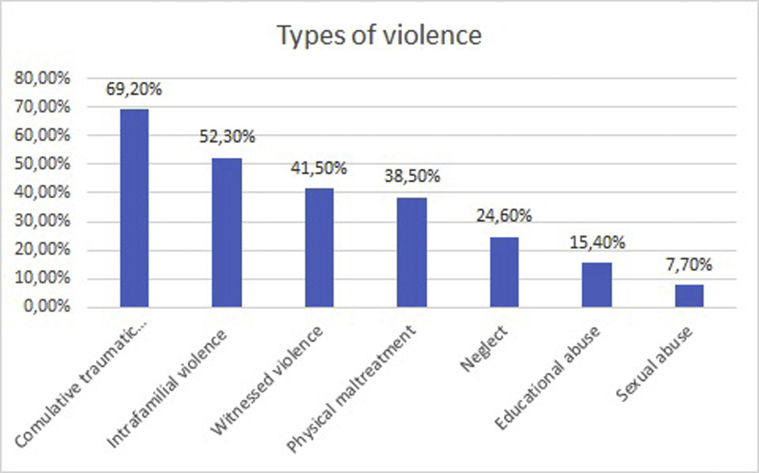
Types of violence.